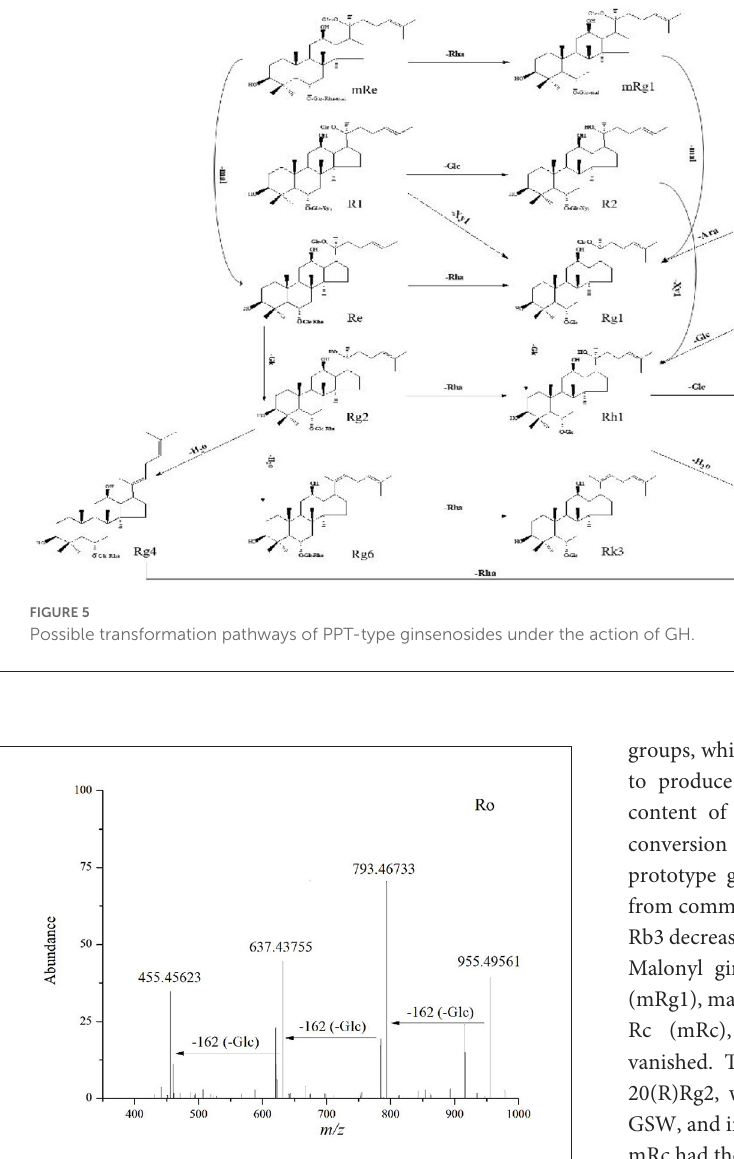
FIGURE6 Tandem mass spectrum of ginsenosides in the negative ion mode: Ro.